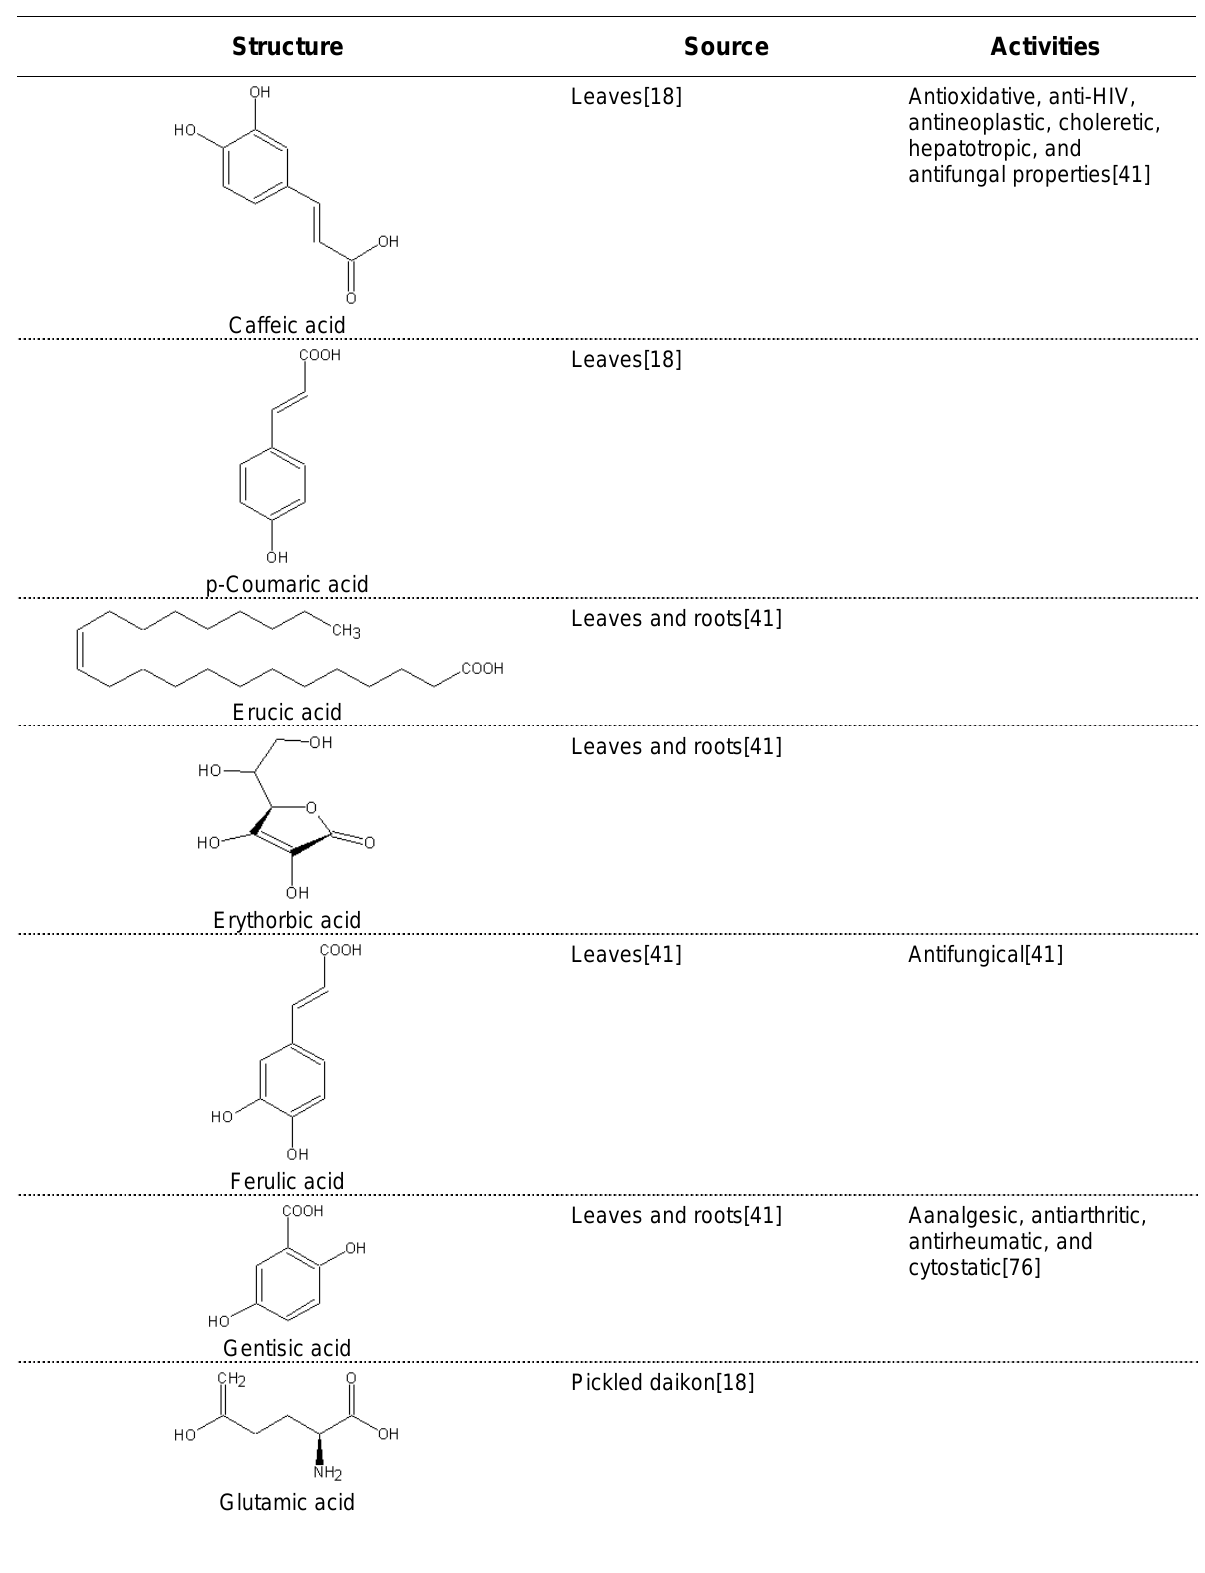
Organic Acid Isolated from